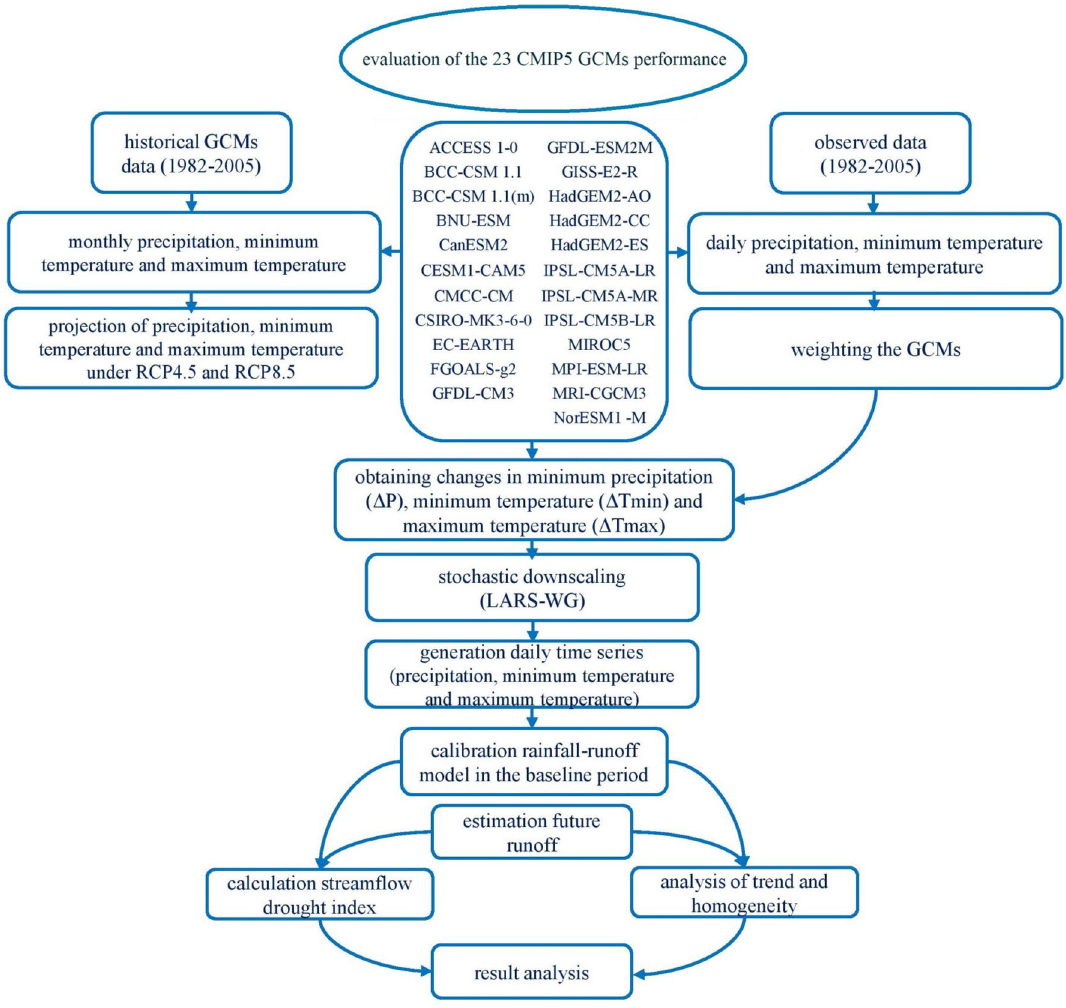
Fig. 1 Flowchart of the methodology followed in this